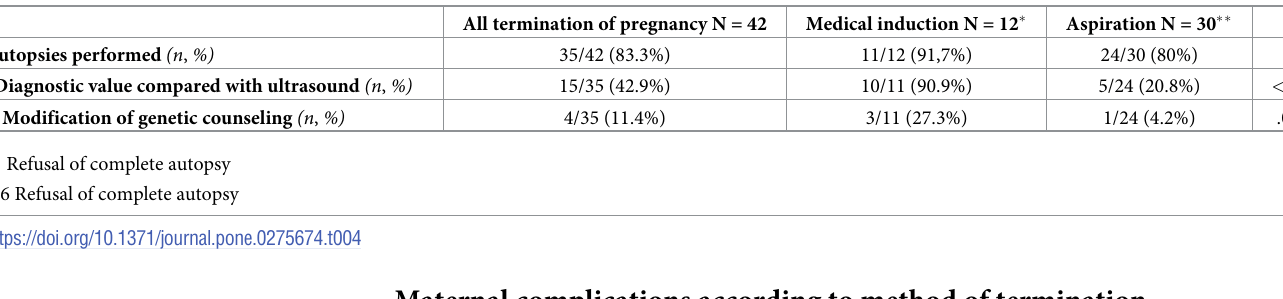
Table 4. Value of fetal autopsy, globally and by method of termination for TOPFA < = 14SA (sensitivity analysis).